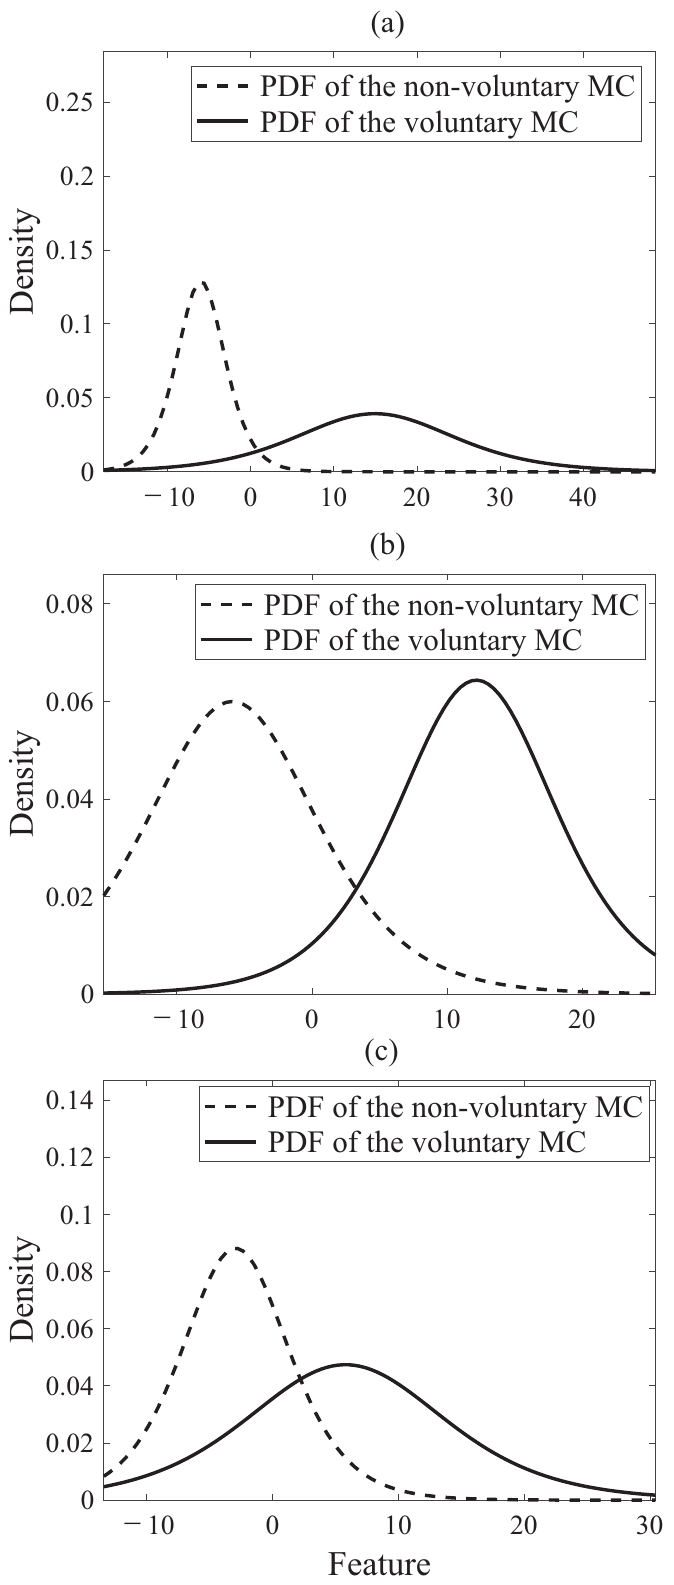
Figure 8. Probability density function (PDF) of the extracted feature. ( a ) PDF in the 10 Hz ES environment, ( b ) PDF in the 60 Hz ES environment, ( c ) PDF in the 90 Hz ES